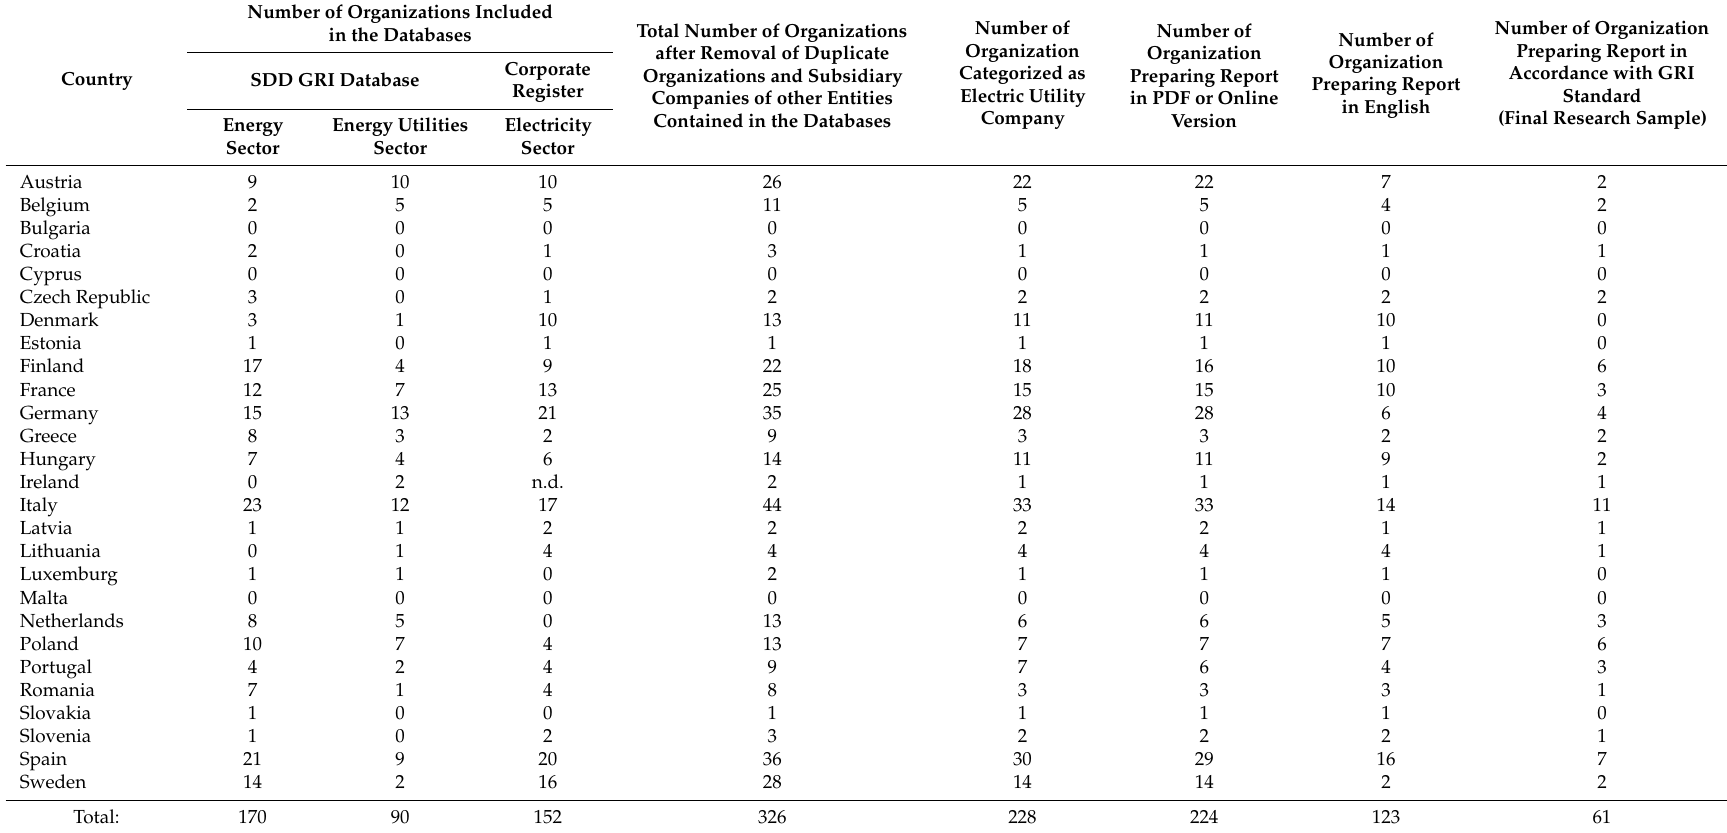
Table A2. Summary of quantitative data from the subsequent steps of selection of research